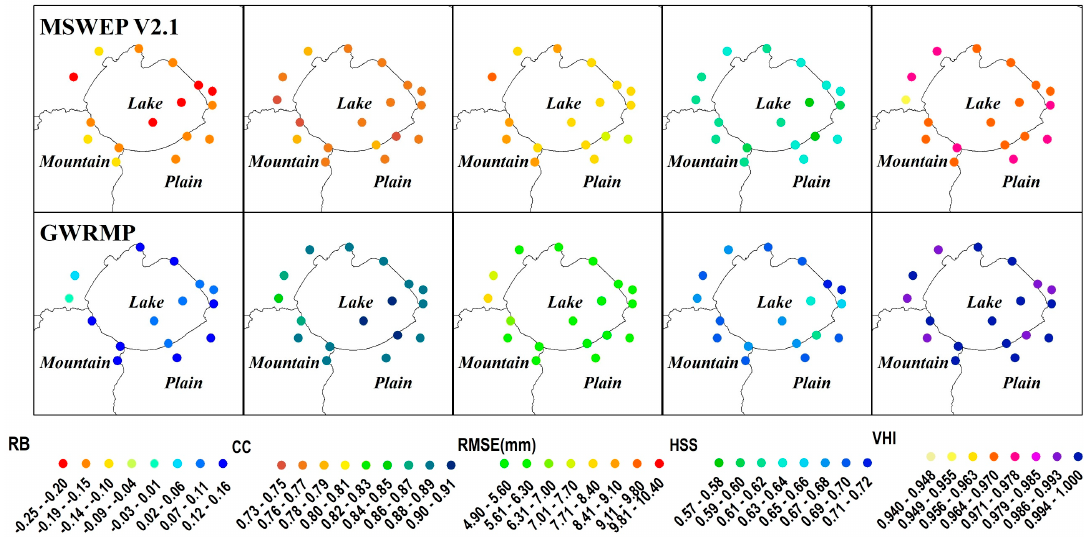
Figure 5. Accuracy of the MSWEP V2.1 and GWRMP at gauged scale in Taihu Lake and coastal area.